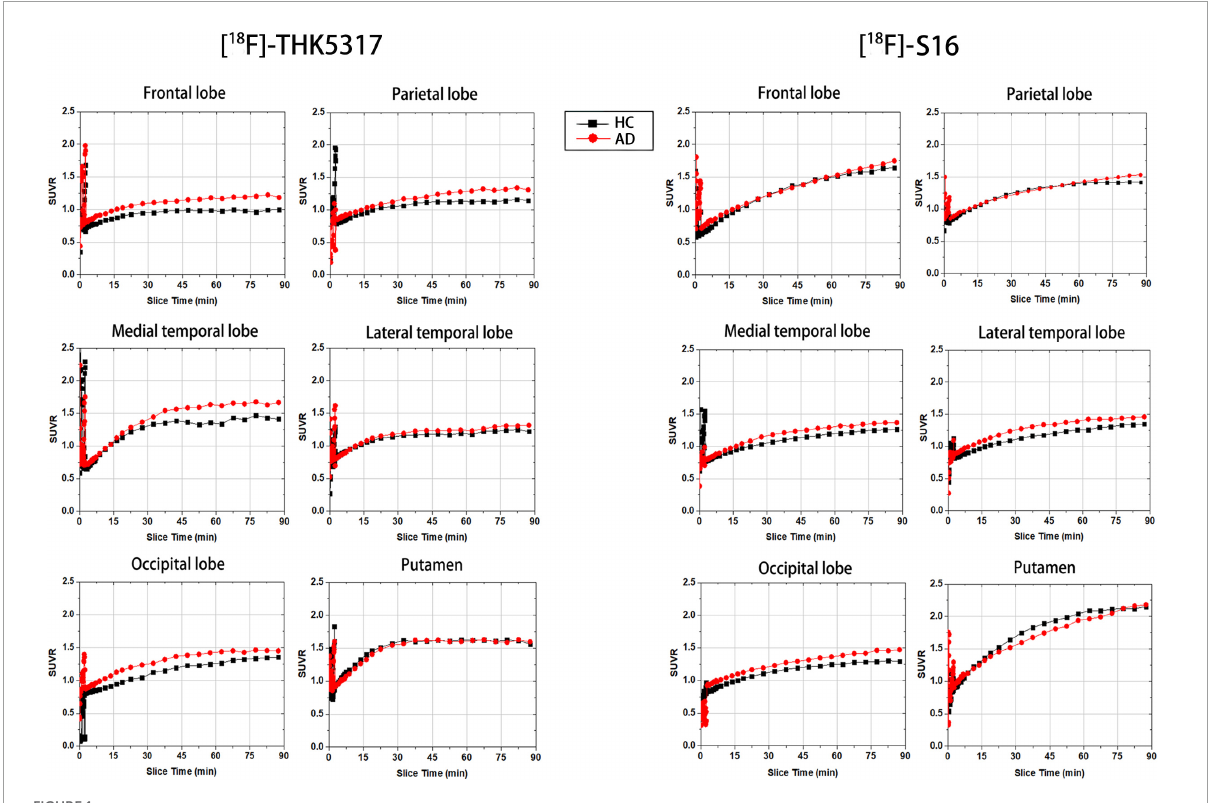
FIGURE1 Time courses for regional SUVRs for two subjects in each diagnostic